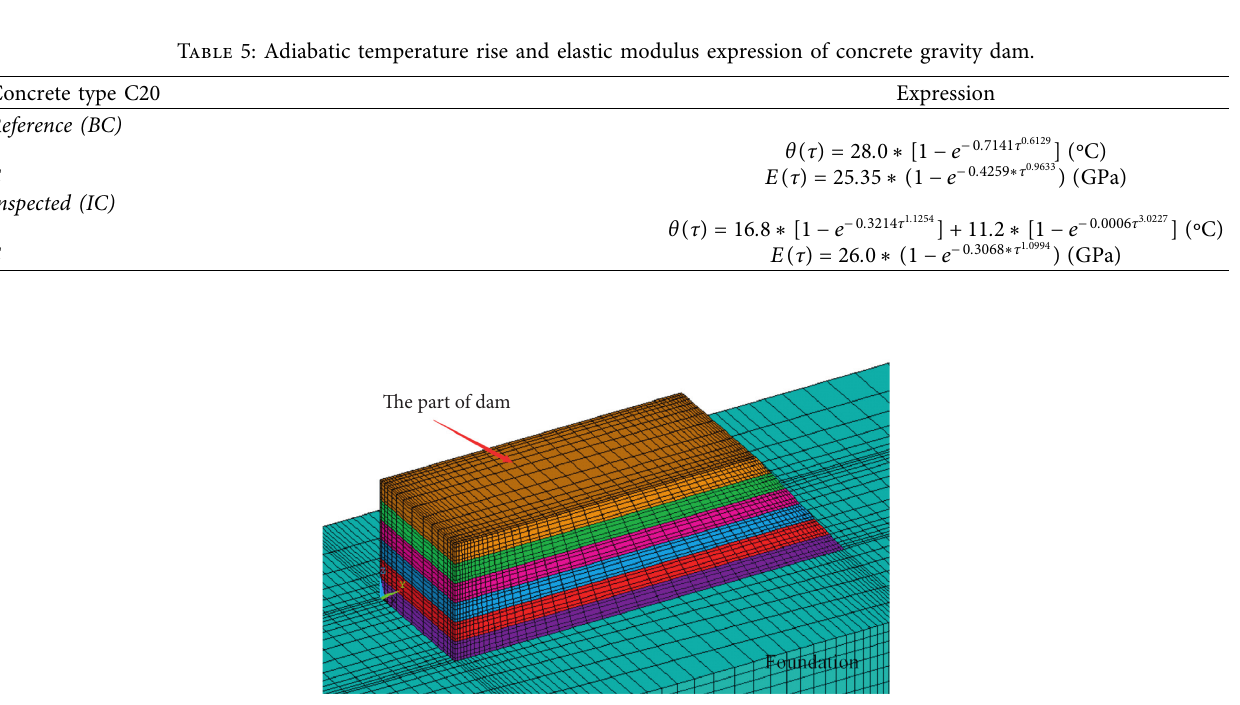
Figure 15: Finite element model of concrete